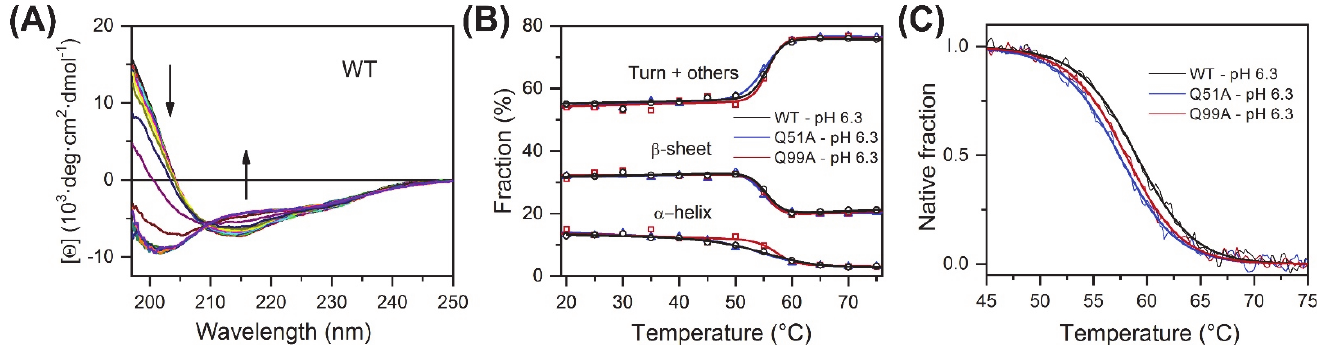
Figure 2. CD spectroscopy of apo human I ‐ BABP variants. ( A ) CD spectra of the WT protein recorded as a function of temperature from 10 °C to 85 °C at 5 °C steps. Arrows show the direction of spectral changes. Temperature dependence for all variants is shown in Supplementary Figure S1A. ( B ) Secondary structure composition was analyzed using the BeStSel method [40,41] as a function of temperature for wild ‐ type hI ‐ BABP and the two mutants. Secondary structure is summed up in three groups, α ‐ helix, β ‐ sheet, and turn+others. ( C ) Overall stability of the variants at pH 6.3 was investigated and compared by thermal denaturation using a continuous heating at a rate of 2 °C/min and followed by the CD signal at 200 nm, which reflects the changes in the β ‐ sheet and disordered structure of the molecule. Thermal stability experiments for pH 5.8, 6.3, and 8.0, are presented in Supplementary Figure S1B.